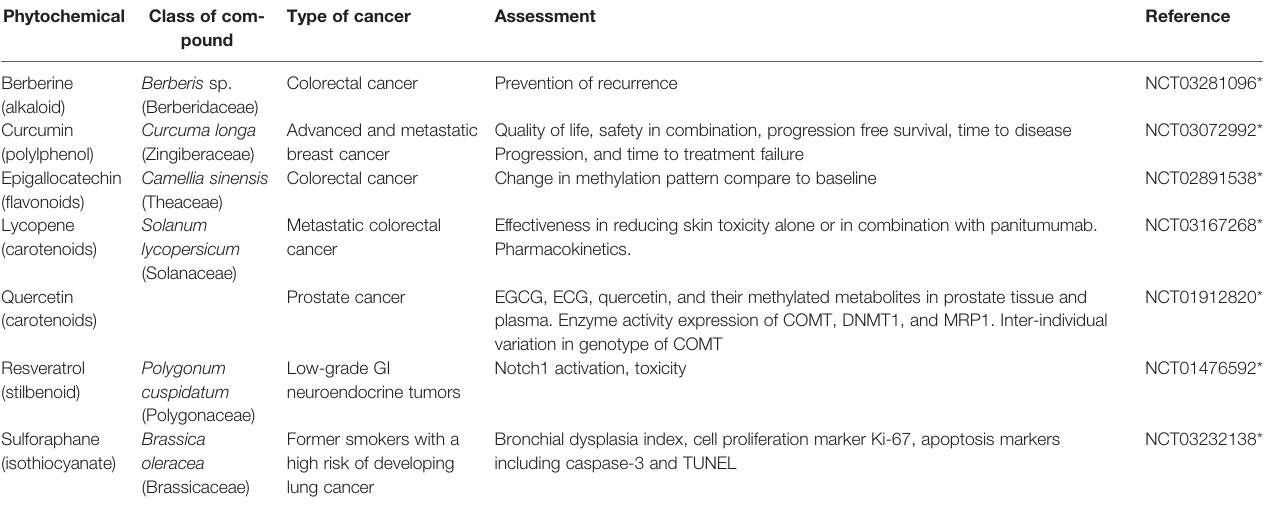
TABLE 3 | List of phytochemicals currently in clinical trial on various cancers. Phytochemical Class of com-